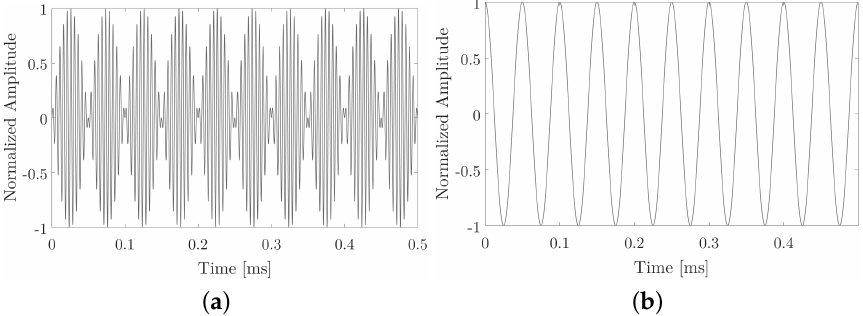
Figure 1. Bit 1 example. ( a ) FSK modulation. ( b ) FSK type signals that want to obtain